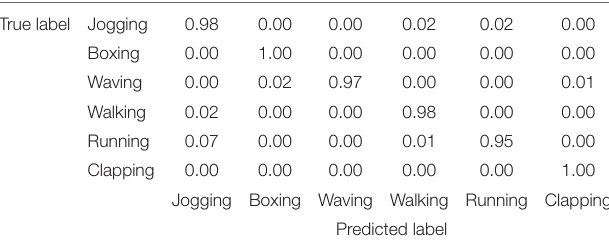
TABLE 5 | Accuracy comparison with different methods on UCF-101 and real scene